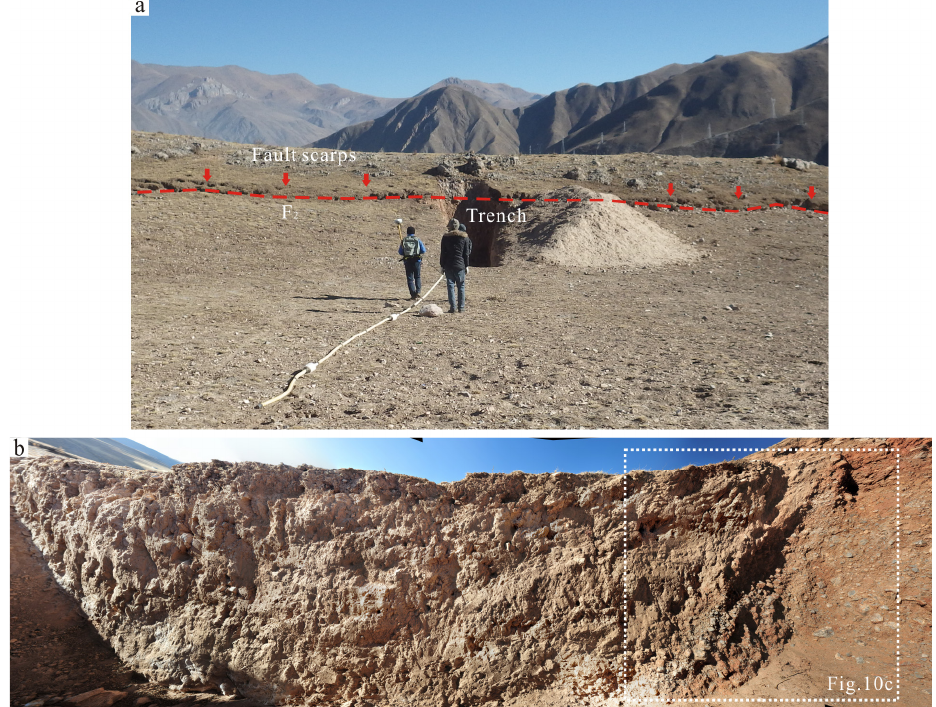
Figure 5. Photomosaic image of trench section. ( a ) The location of trench wall. Red dotted lines are the identified fault F 2 . ( b ) Trench section (the western wall). White rectangular box indicates the detailed logging of fault F 2 in Figure 10c.